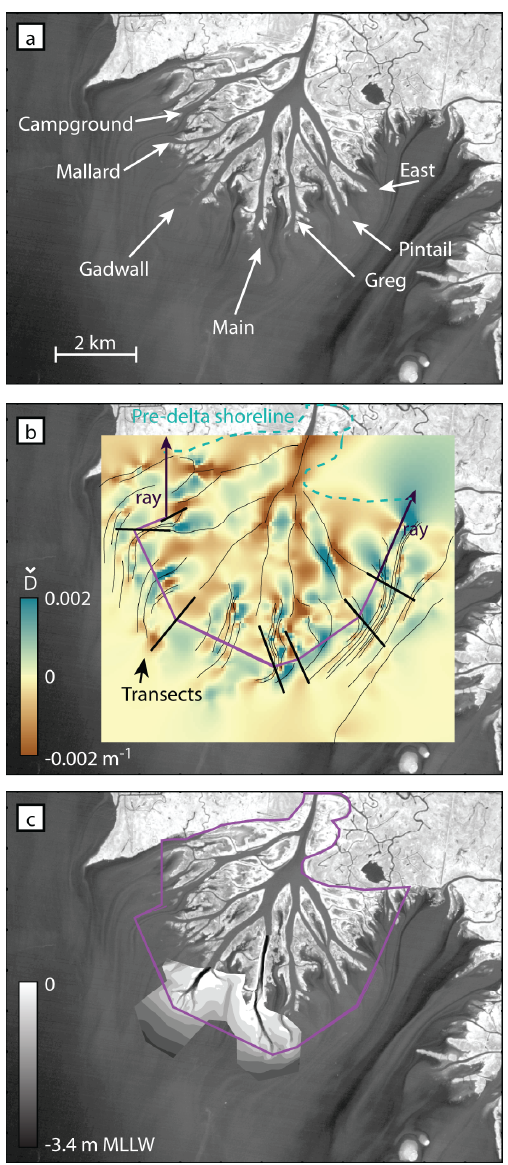
Figure 3. Method for converting imagery into channel tips and delta area. (a) Landsat image displaying streak lines (14 Octo- ber 2010; Supplement). The seven primary distributary channels are labeled. (b) Streak lines (thin black lines) are mapped manually on the delta front, and lines are also placed down the center of sub- aerially emergent distributary channels. The ˇ D field is interpolated from these streak lines (color map). Thick black lines are transects extending from the seven primary distributary channels. The esti- mated location x ˆ η along each transect is connected via the purple line and rays connect channel tips to the pre-delta shoreline to close the area. (c) The interpreted total delta area is shown. A bathymetric map from June 2010 referenced to mean lower low water (MLLW) shows how the interpreted channel tips compare to direct measure-